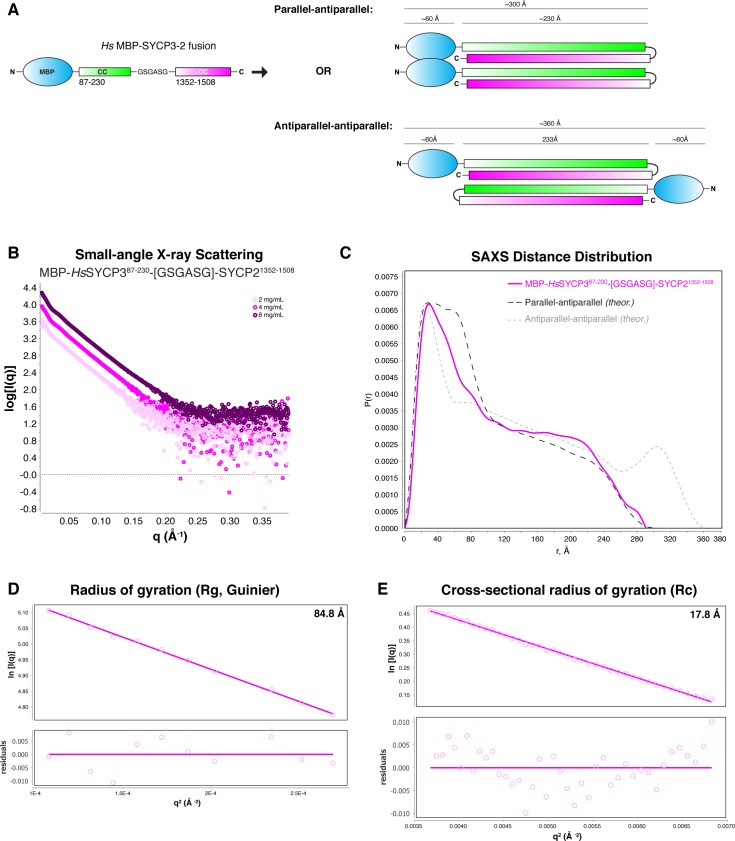
SAXS analysis of Hs His6-MBP-SYCP3CC-SYCP2CC fusion.(A) Schematic models of two possible orientations of subunits in the His6-MBP-SYCP3CC-SYCP2CC fusion complex. In the ‘parallel-antiparallel’ model (top), the two His6-MBP tags are located on the same end of the complex. In the ‘antiparallel-antiparallel’ model, the two His6-MBP tags are located on opposite ends of the complex. (B) Small-angle x-ray scattering (SAXS) curves on the Hs His6-MBP-SYCP3CC-SYCP2CC fusion complex, at three different protein concentrations. (C) Intra-particle distance distribution of Hs His6-MBP-SYCP3CC-SYCP2CC fusion (magenta), compared to the calculated distance distribution for the ‘parallel-antiparallel’ (dark grey) and ‘antiparallel-antiparallel’ (light grey) models. (D) Guinier analysis of the low-scattering-angle region to determine radius of gyration (Rg) (Feigin and Svergun, 1987). (E) Cross-sectional radius of gyration (Rc) analysis (Glatter and Kratky, 1982).